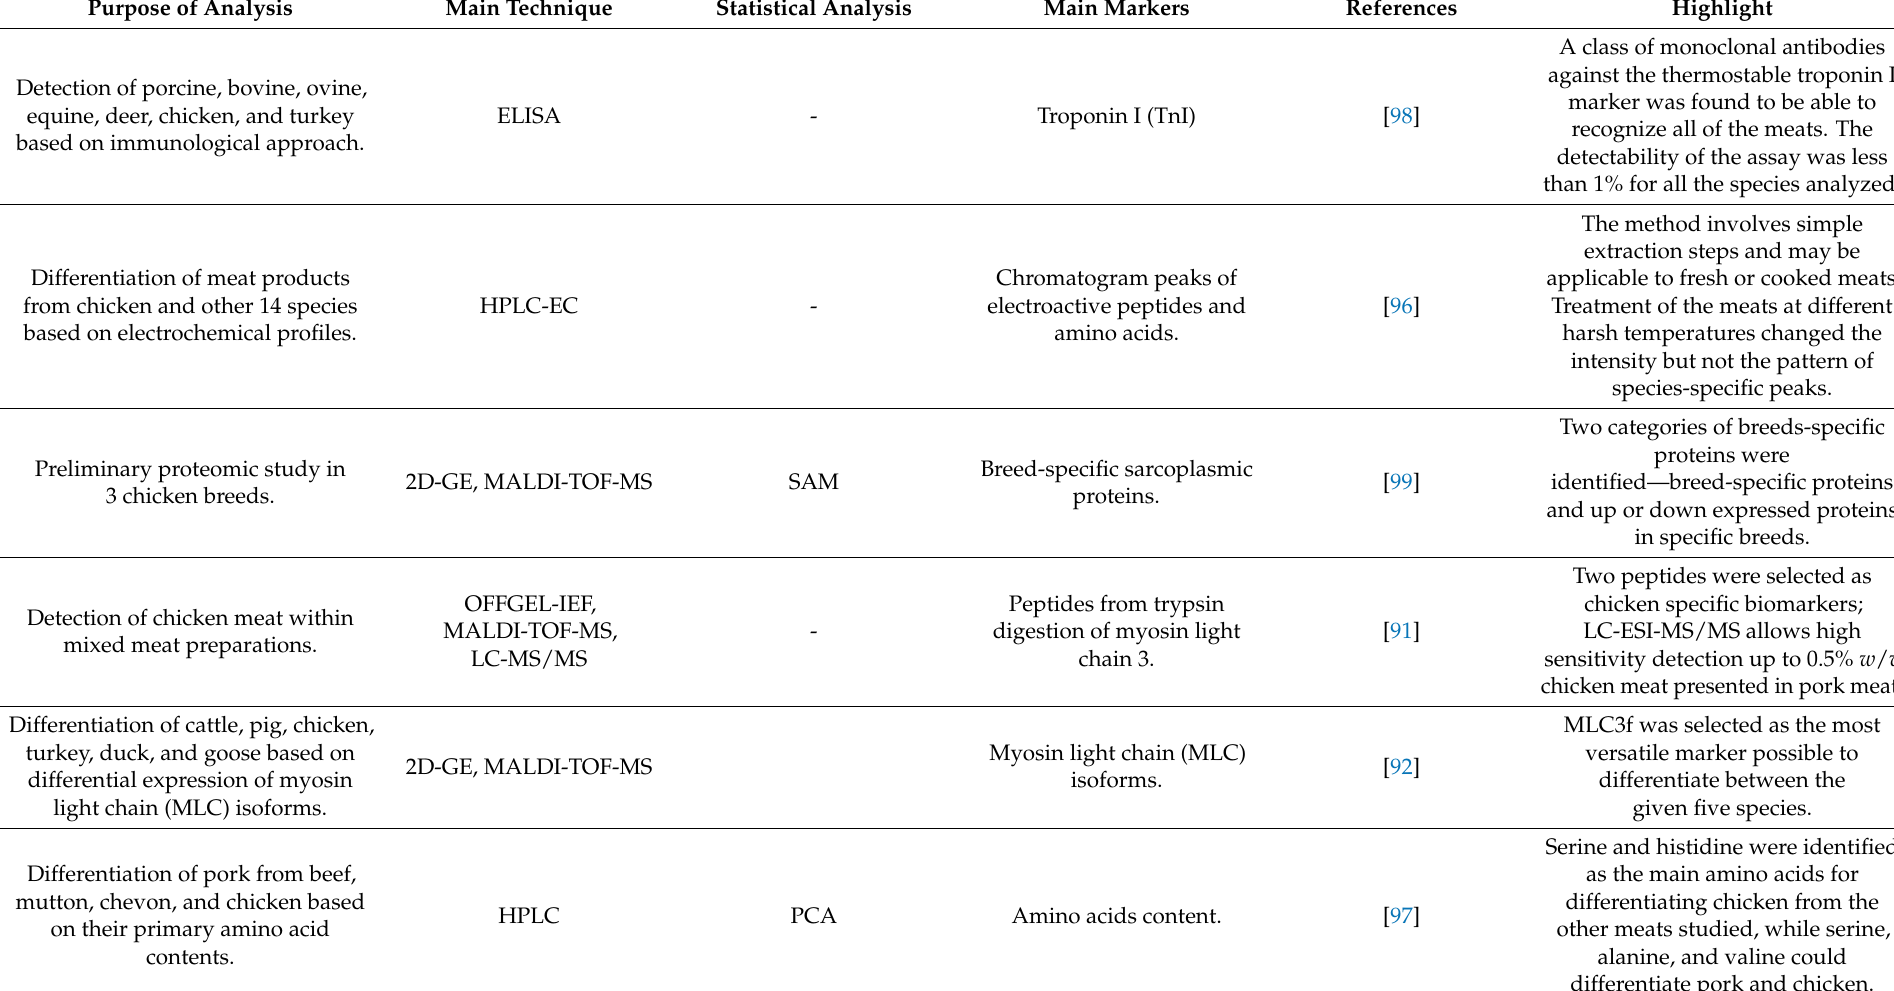
Table 3. Summary of proteomics application in chicken authentication. Type of samples and performance (limit of detection and discriminating accuracy) are included where